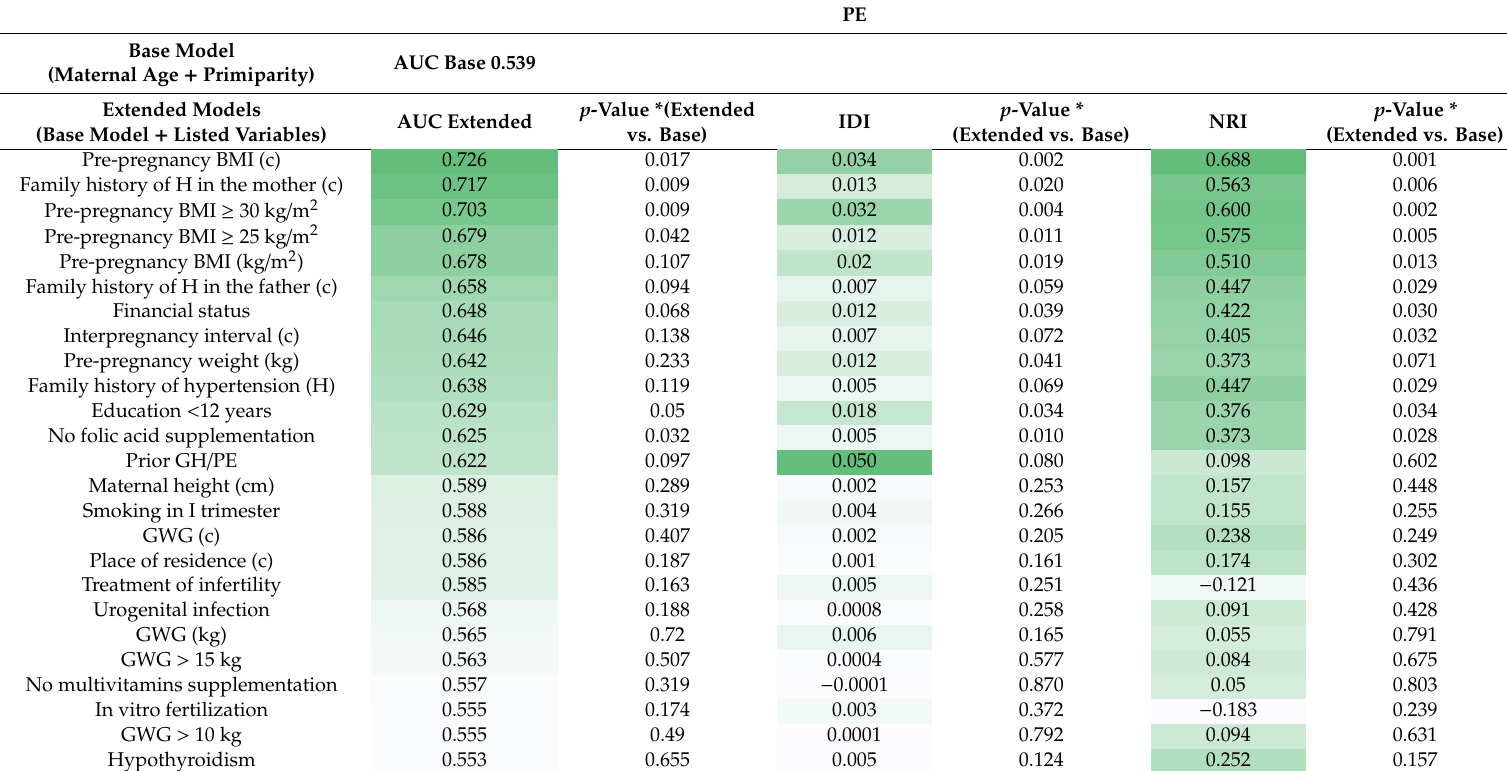
PE AUC Base 0.539 p -Value *(Extended p -Value * p -Value * AUC Extended IDI NRI vs. Base) (Extended vs. Base) (Extended vs. Base)